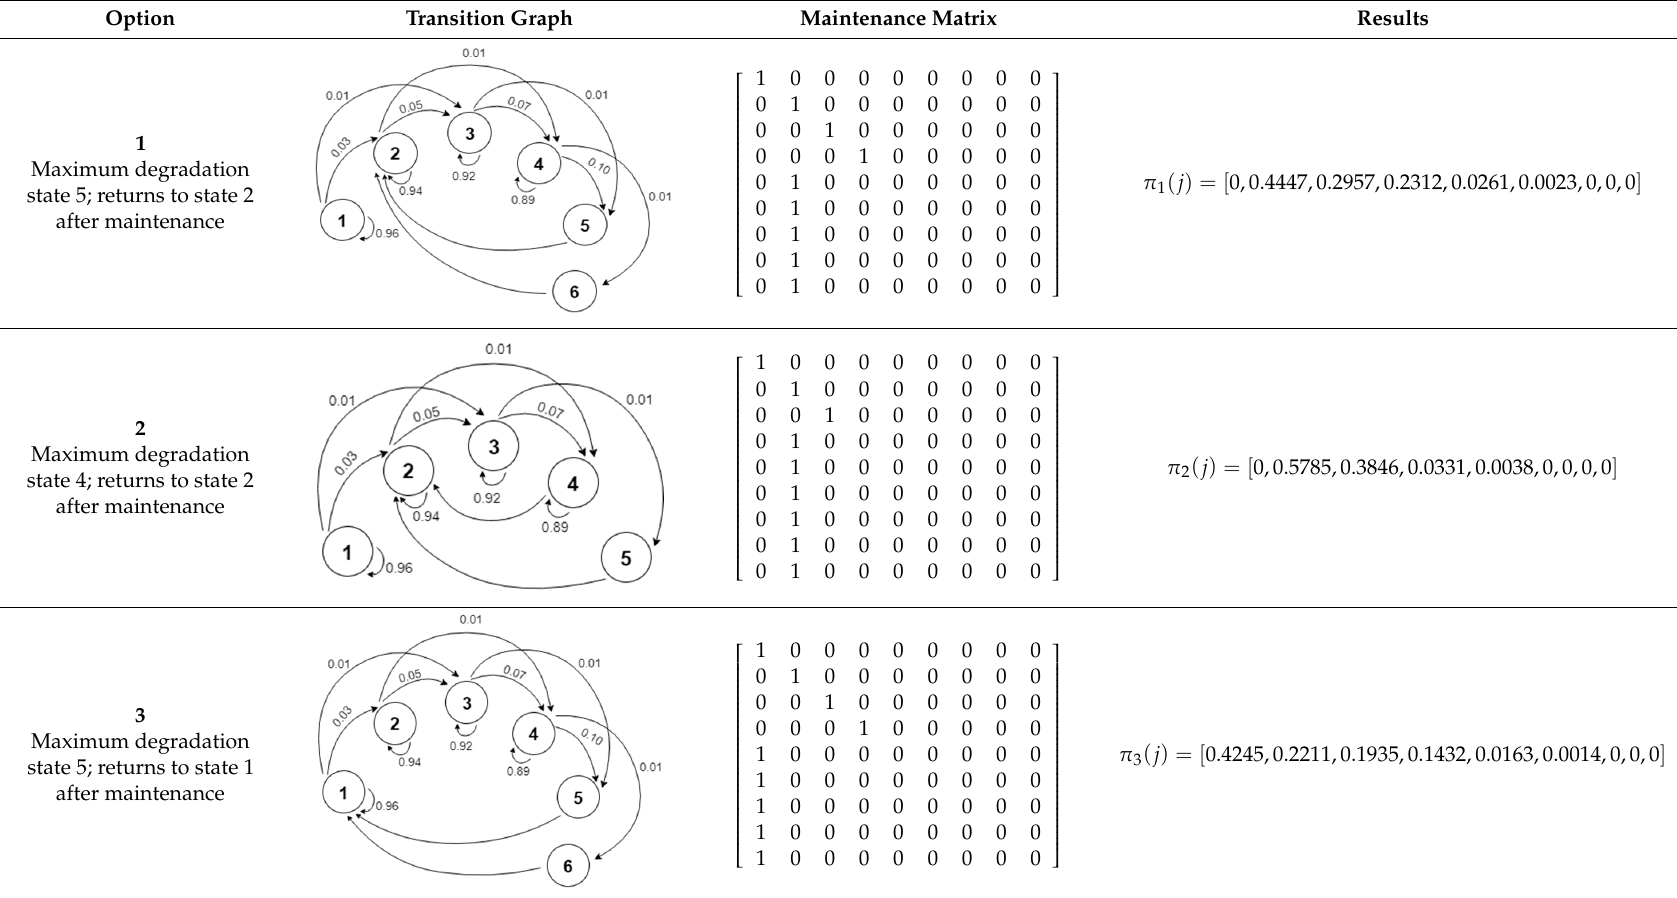
Table 2. Results obtained from the di ff erent maintenance strategies analyzed. Table 2. Results obtained from the different maintenance strategies analyzed. Table 2. Results obtained from the different maintenance strategies analyzed. Table 2. Results obtained from the different maintenance strategies